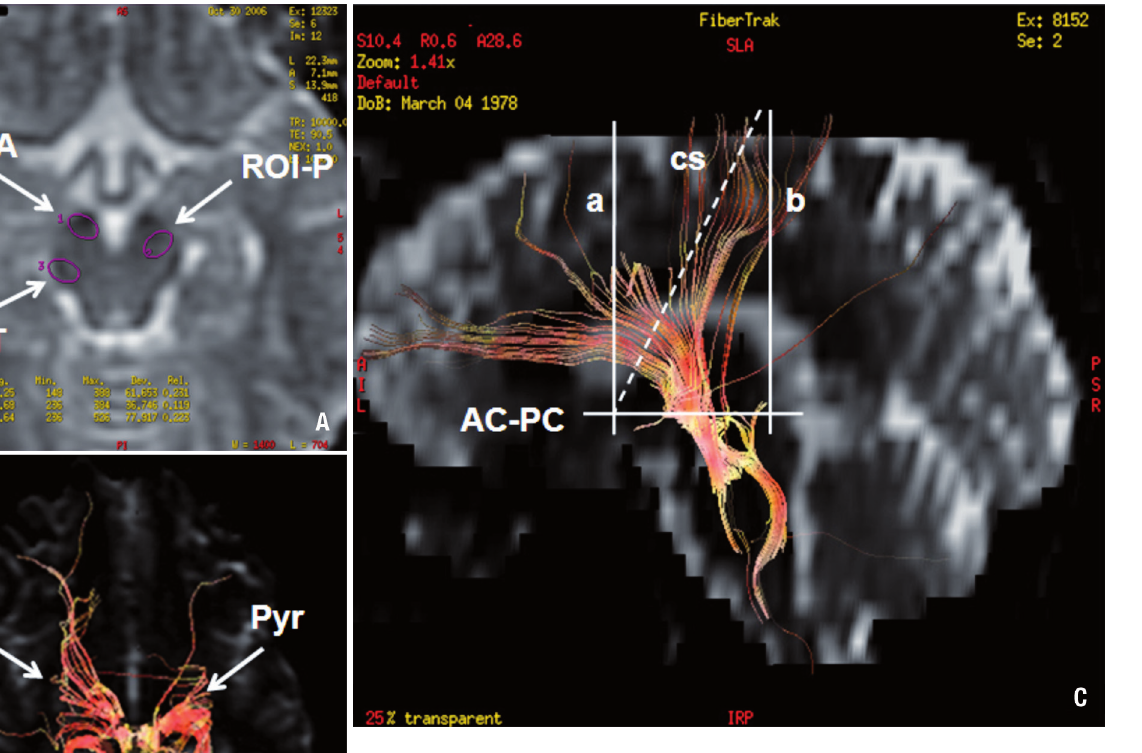
Figure 2. [ A] Localization of ROIs at the cerebral pes pedunculi (EPI axial view). [B] Tractograms - axial view. Arrows - right side point to the seeding ROIs and to Arnold’s (Arn) and Türck’s (Tür) bundles, and left side arrows, the seeding ROI and to the cortico-(bulbo)-spinal tract (Pyr). [C] Arnold’s bundle tractogram (sample) - solid line (limit between premotor and prefrontal region) and broken line (projection of the central sulcus - posterior limit of the frontal lobe). AC: anterior commissure; PC: posterior commissure; AC-PC: anterior commissure-posterior commissure line; a: anterior commissure plane; b: posterior commissure plane; cs: central sulcus